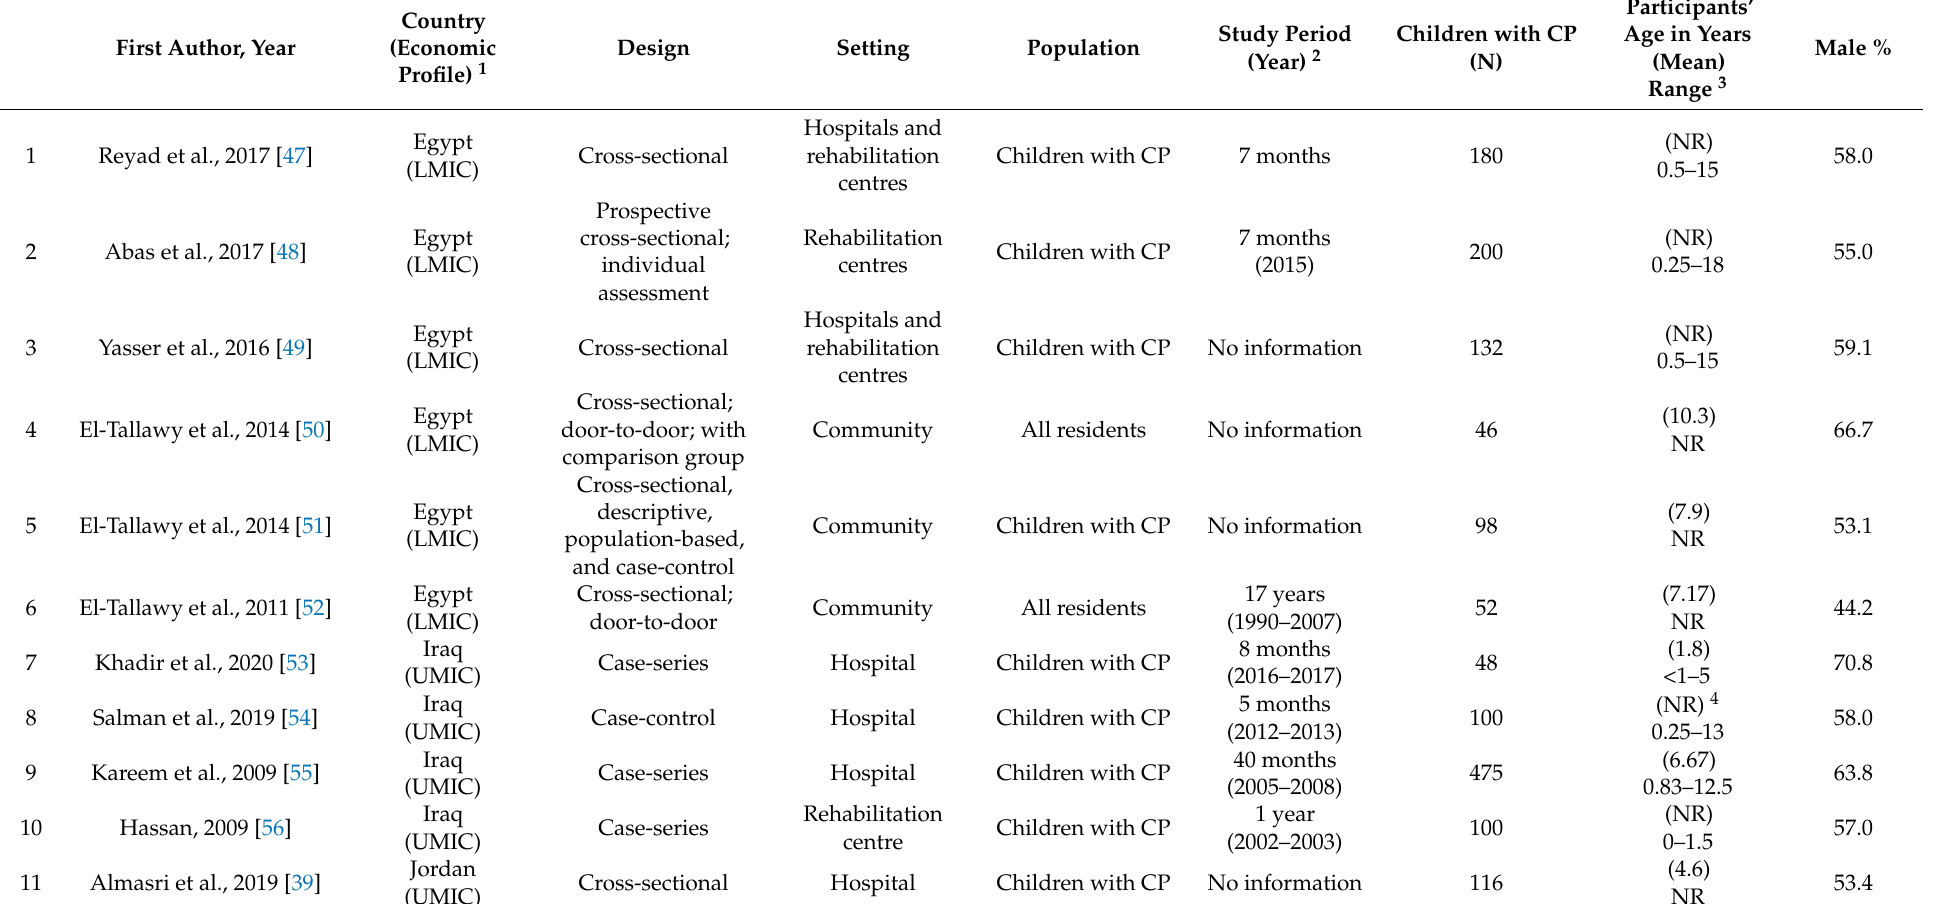
Table 2. Characteristics of included publications (alphabetically ordered by country